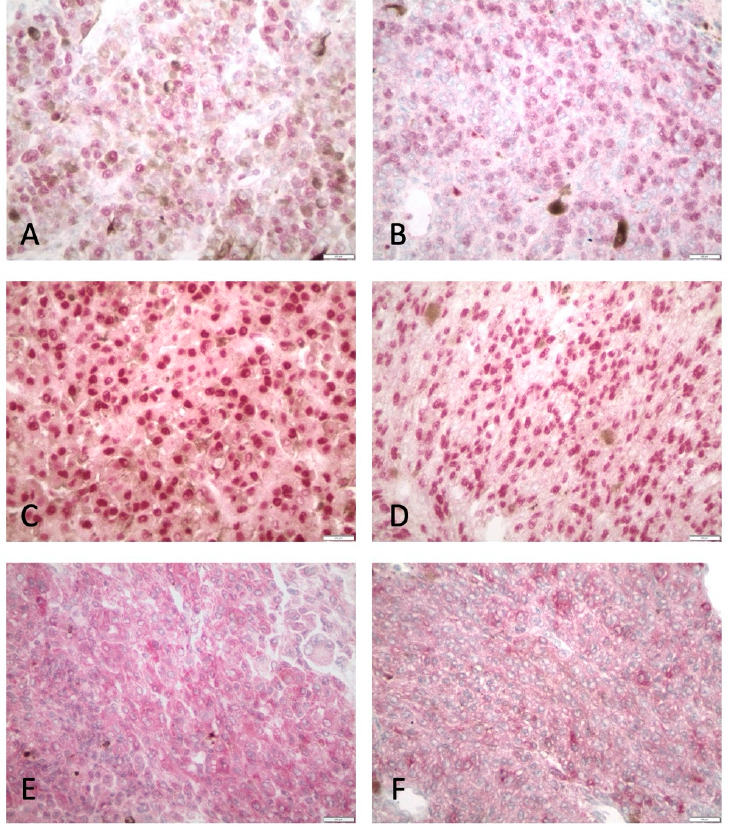
Figure 1. Immunohistochemical expression of HDAC-1, -2, -4 and -6 in UMs. ( A ) Nuclear HDAC-1 expression, ( B ) nuclear and cytoplasmic HDAC-2 expression, ( C ) strong HDAC-2 expression in epithelioid-cell UM, ( D ) HDAC-2 expression in spindle-cell UM, ( E ) cytoplasmic HDAC-4 expression, ( F ) cytoplasmic HDAC-6 expression (×200). Table 2. Immunohistochemical expression of HDAC-1, -2, -4, and -6 in UMs. Parameter